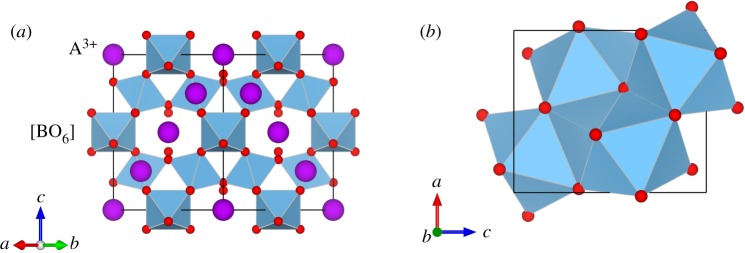
The crystal structures of A2B2O7 oxide: (a) the pyrochlore structure and (b) the cotunnite-like structure. The purple balls are A3+ cations and the blue octahedrons are [BO6]. Small red balls are oxygen ions. In the cotunnite-like A2B2O7 structure, the A and B cations are disordered and 1/8 of the O2− vacancies are randomly distributed.